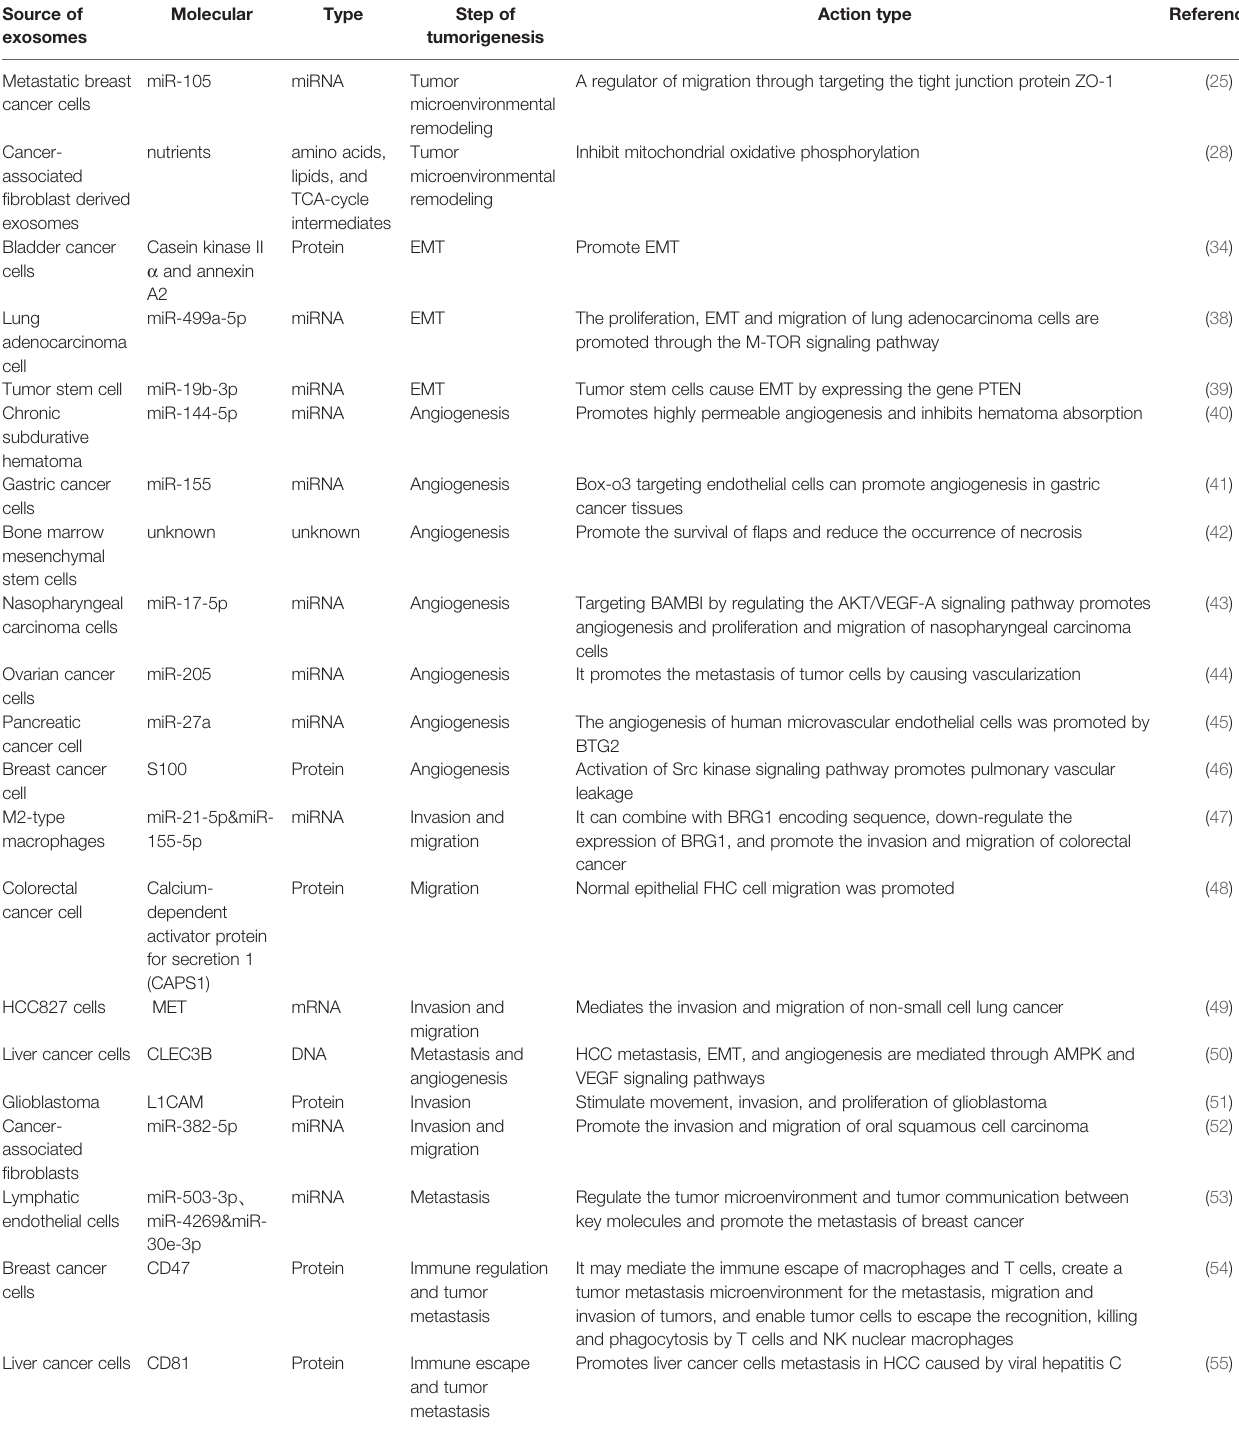
TABLE 1 | Roles of exosomes in cancer